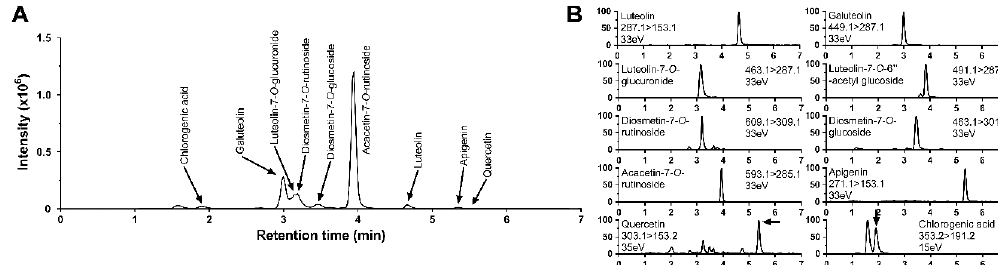
Figure 1. The total ion chromatogram ( A ) and selected reaction monitoring chromatogram ( B ) of individual flavonoids from Chrysanthemum morifolium Ramat leaf extracts (CLE).